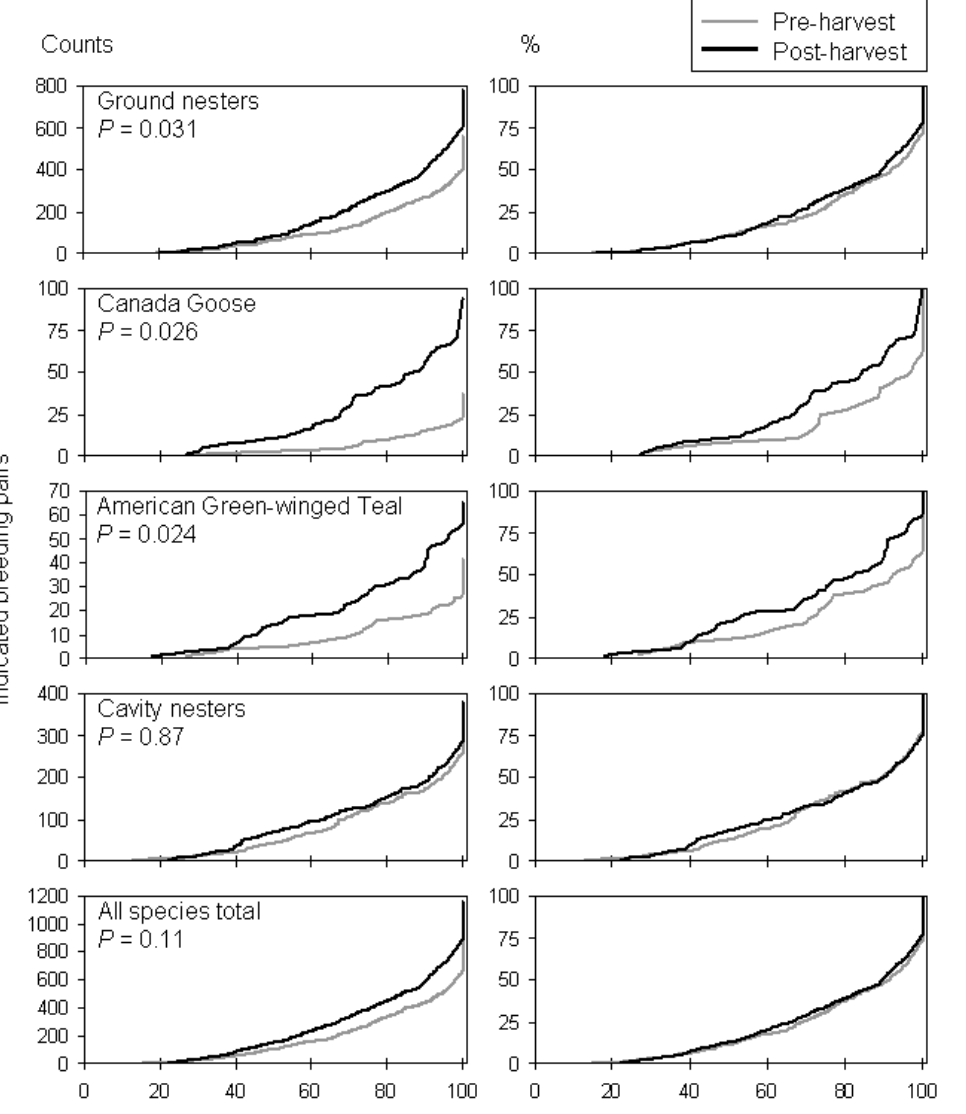
Fig. 4. Indicated breeding pairs (IBP) cumulative numbers (left column) and percentages (right column) plotted against percentage of nesting habitat undisturbed by timber harvest for both pre- and post-harvest periods. For example, 92 indicated breeding pairs of ground nesters, representing 16% of all pairs detected within 2000 m, had more than 60% of undisturbed nesting habitat for the pre-harvest period. These values changed to 141 IBP and 18%, respectively, post-harvest. P -values are that of the Mann- Whitney U -tests. It is worth noting that in all cases, curves of IBP raw counts were higher post-harvest than pre-harvest, and post-harvest relative counts (%) had a generally lower percentage of nesting habitat left undisturbed by timber harvesting than pre-harvest relative